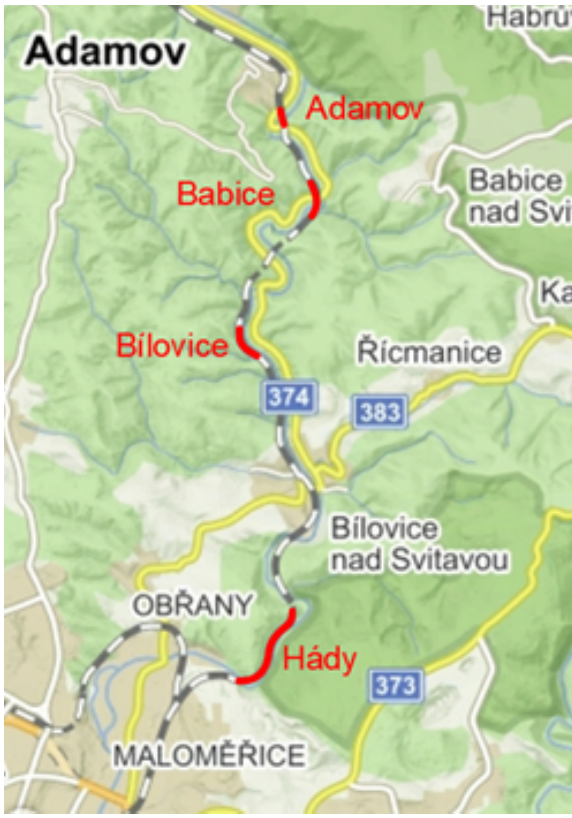
Figure 1. Placement of the sections on the railway line No. 326 (Brno – Česká Třebová).